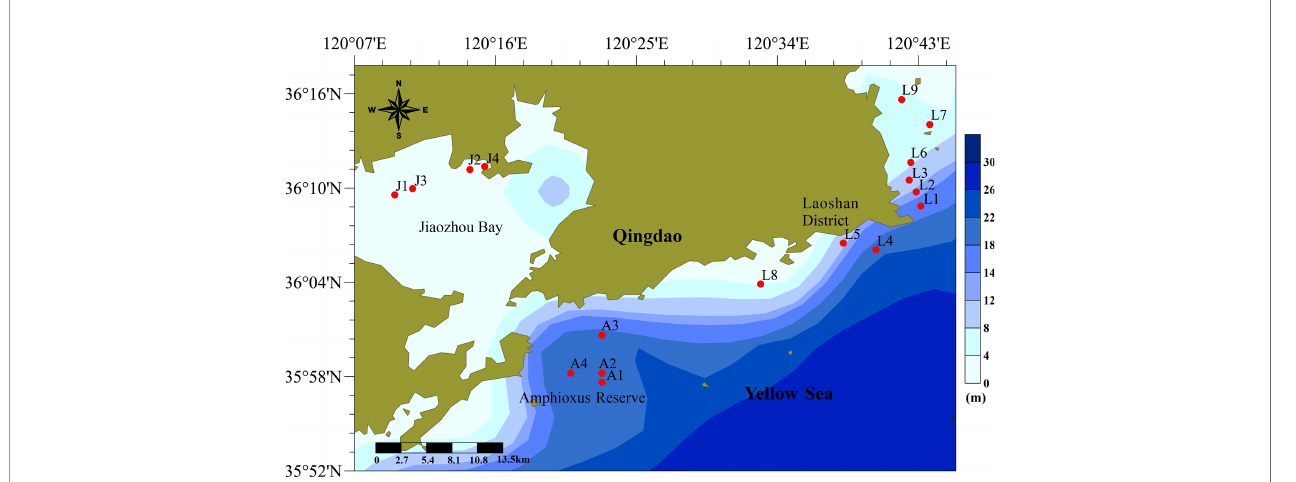
FIGURE 1 | Sampling stations in the Qingdao coastal sea area. Stations J1 – J4 are in the inner Jiaozhou Bay, stations A1 – A4 are in the Amphioxus Reserve area, and stations L1 – L9 are in the Laoshan